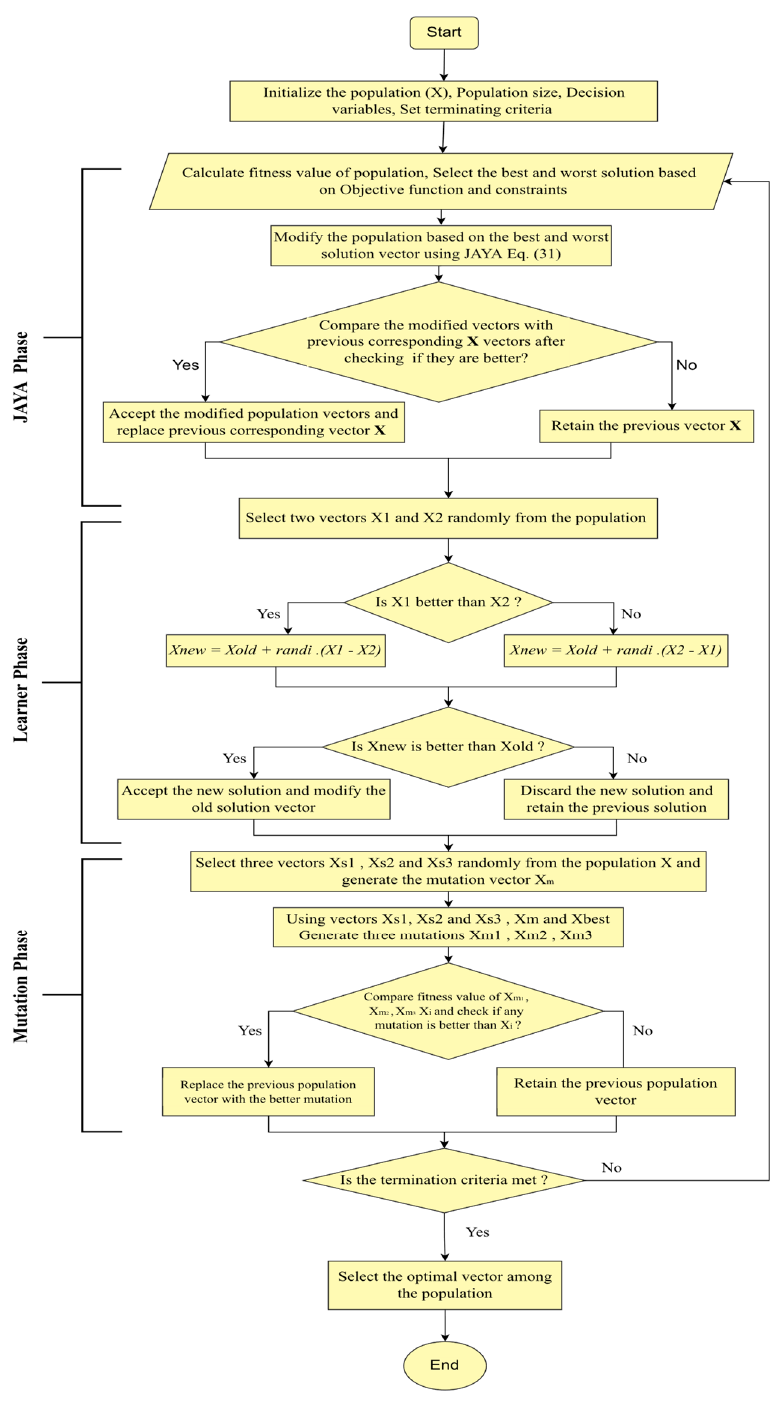
Figure 6. Flow chart of MJLBO algorithm.